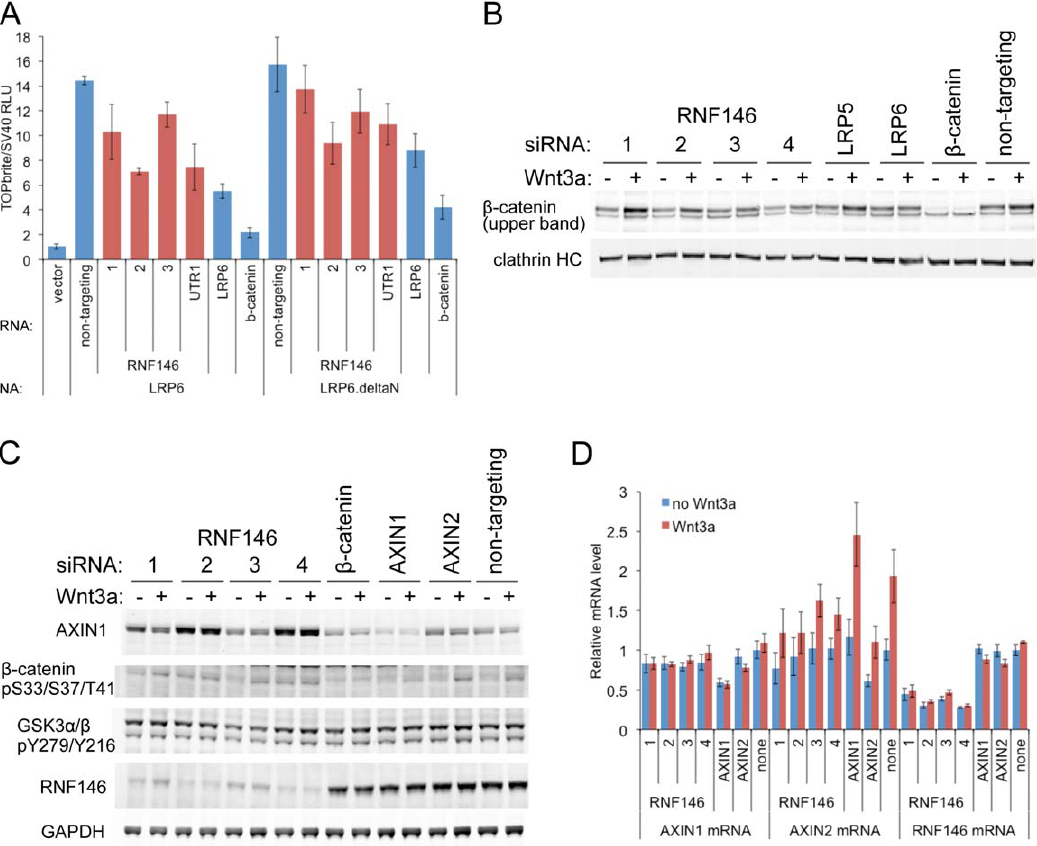
Figure 2. RNF146 acts in the Wnt pathway at the level of Axin protein destabilization. (A) Effects of individual RNF146 (red) and control (blue) LRP6, b -catenin, or non-targeting siRNAs on Wnt reporter activity in HEK293 cells stably expressing TOPbrite and SV40 reporters, and transiently transfected with expression construct for either wildtype LRP6 or a constitutively active LRP6 with the extracellular domain deleted (deltaN). (B) Western analysis of the effects of individual RNF146 siRNAs on b -catenin stabilization induced by Wnt3a ( + ) in HEK293 cells. LRP5 and LRP6 siRNAs are used as negative and positive controls, respectively, since Wnt signaling in HEK293 cells depends on LRP6 and not LRP5 [17]. b -catenin siRNA indicates that the higher molecular weightband in thepanel corresponds to b -catenin protein. Clathrin heavy chain immunoblotting was used as a gel loading control. (C) Western analysis of AXIN1, RNF146, b -catenin phosphoshorylated on Ser33, Ser37, and Thr41, and active GSK3 a / b auto-phosphorylated on Tyr279/216 after transfection of individual RNF146 siRNAs in HEK293 cells with ( + ) or without ( 2 ) Wnt3a stimulation. b -catenin and AXIN1 RNAi confirm the specificity of the antibodies. GAPDH was used as a loading control. (D) qRT-PCR analysis of AXIN1, AXIN2, and RNF146 mRNA after transfection of individual RNF146 siRNAs in HEK293 cells. Note that AXIN2 expression is weakly induced by Wnt3a (red), and this response is regulated by the RNAi treatments.